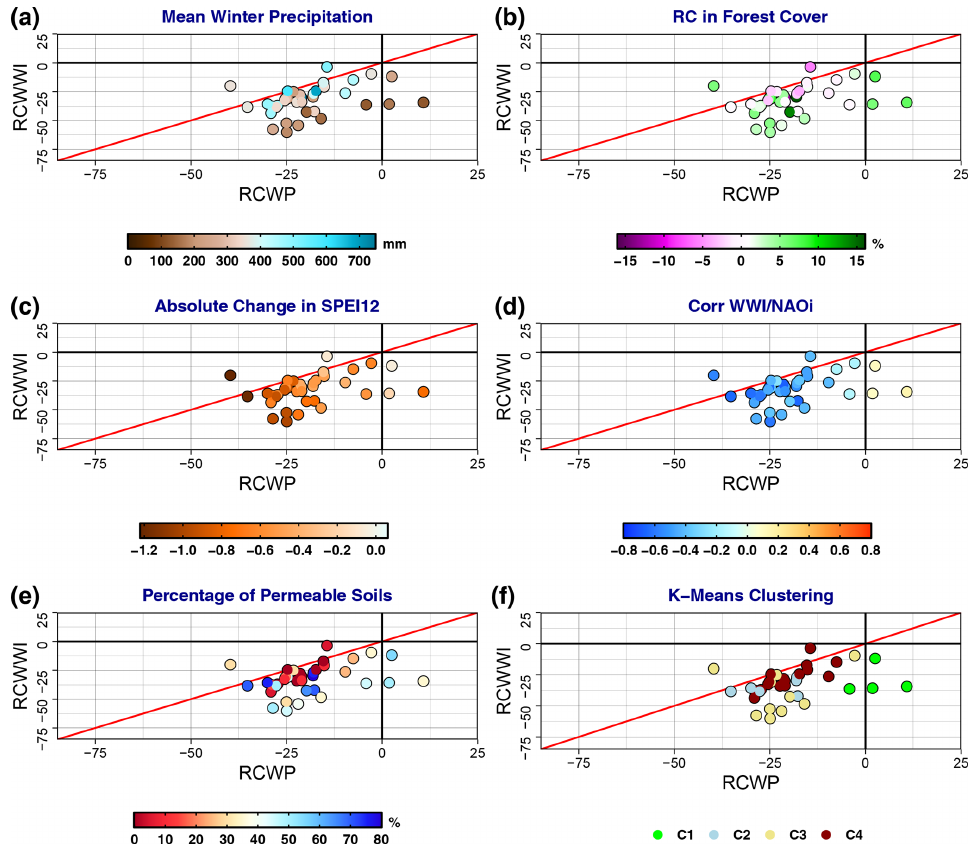
Figure 7. Scatterplot of relative changes in WP ( x axis) and WWI ( y axes). Symbols are colour-coded by the magnitude of several variables: (a) mean WP, (b) RC in forest cover computed following Eq. (6), (c) absolute change in SPEI12, (d) correlation between WWI and NAOi, (e) percentage of permeable soils, and (f) K-means clustering depending on the above-mentioned variables.